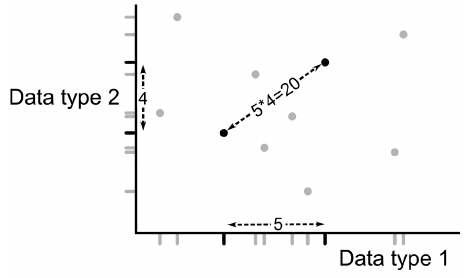
Figure 3. Graphical representation of the dissimilarity measure between cases. Shown is a dataset of nine cases and two (one- dimensional) data types. For each of the two data types, the dissimilarity between the two black cases is given as the number of cases in between them (for that data type), including one of the two black cases. This definition ensures the dissimilarity between a case and itself is zero. The total dissimilarity between the black cases is then given as the product of these, here